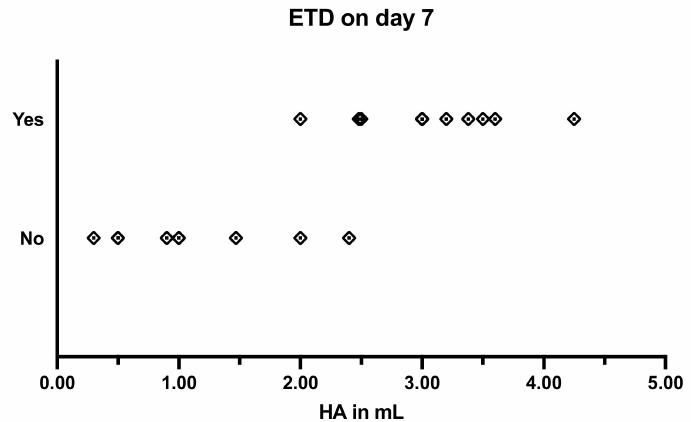
Figure 8. Success of the induction of ETD 7 days after injection of different amounts of HA.